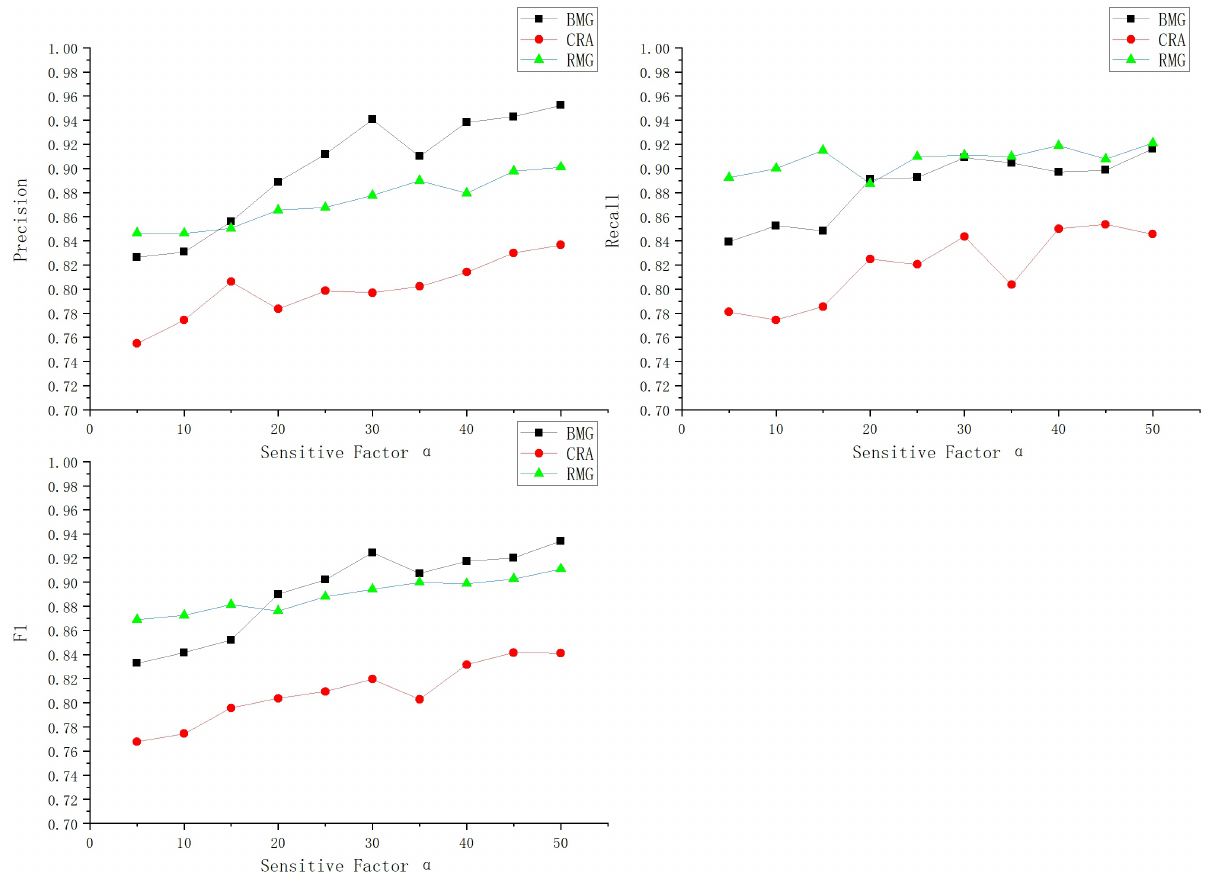
Figure 6. F1-score, Recall, and Precision under different cost sensitive factors α